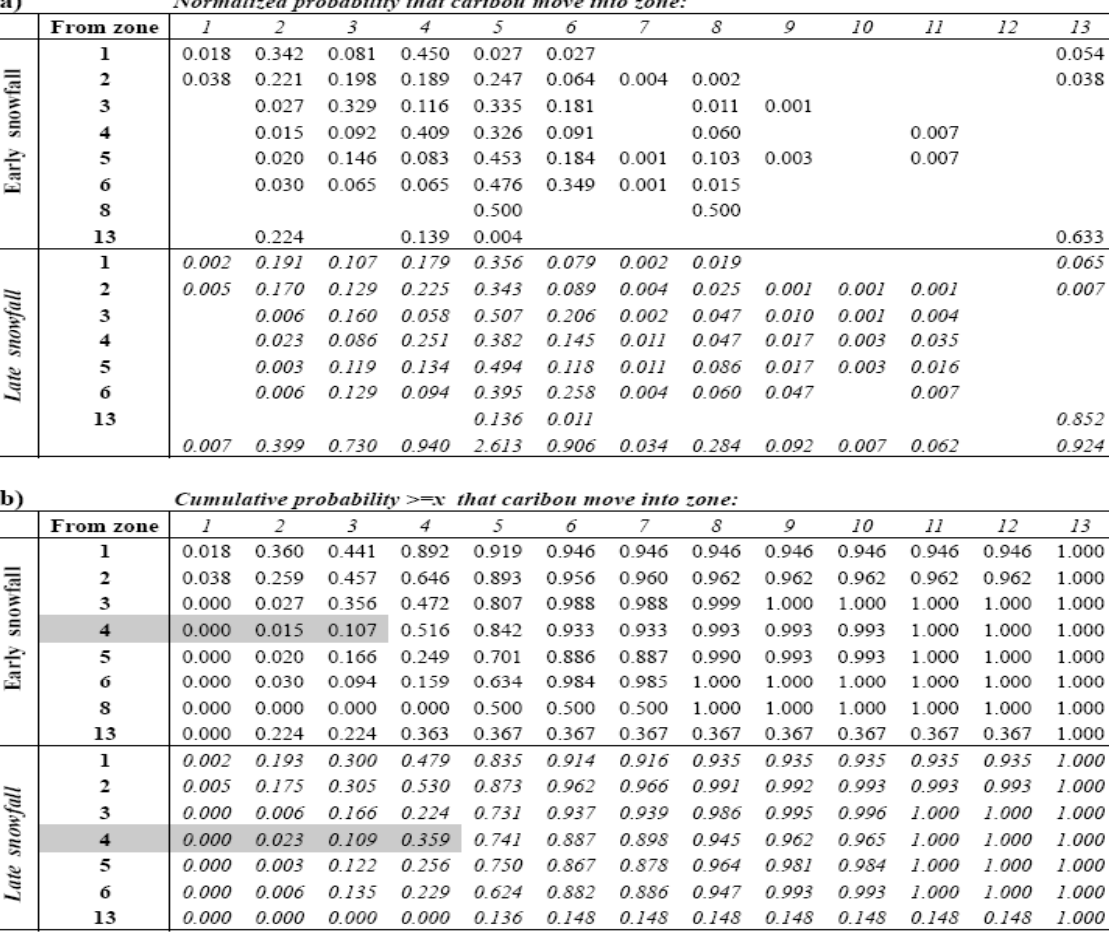
Table A1.1 ( a ) Transition table for fall migration season (Aug 8-Oct 7) for two environmental conditions: early and late snowfall. ( b ) Cumulative probability table for model lookup. Shaded rows indicate the numbers used in the